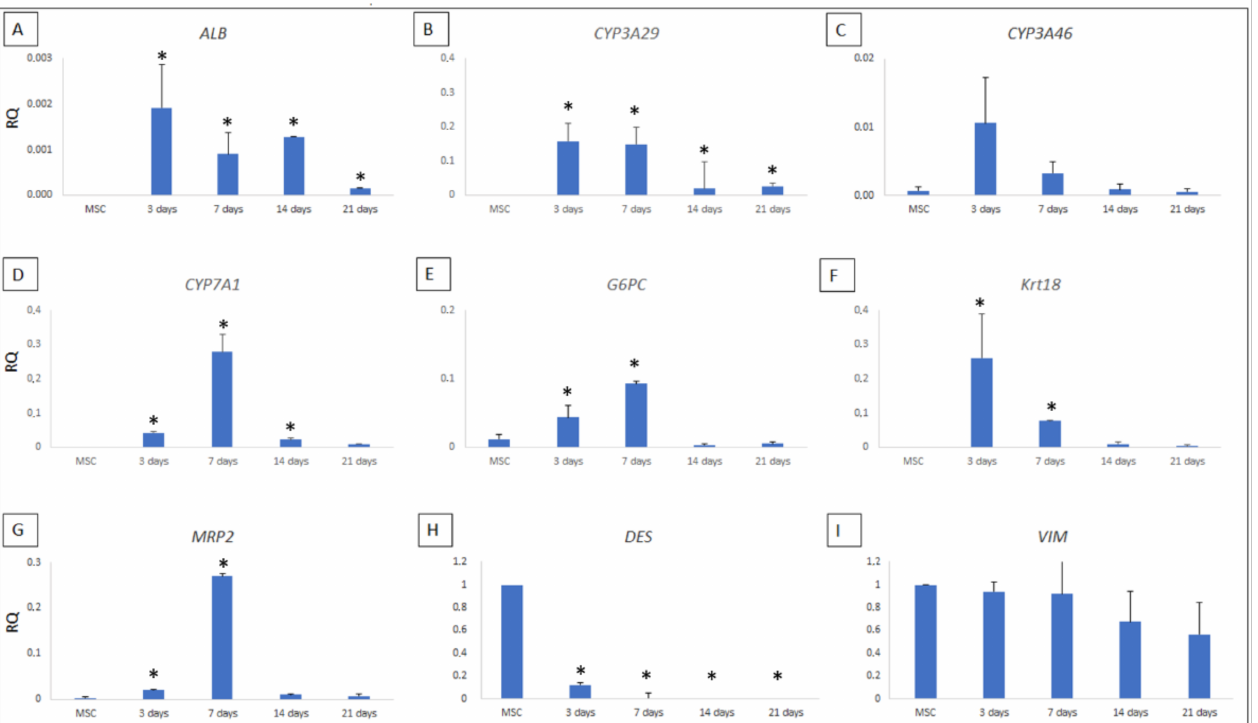
Figure 5. RT-PCR analysis of hepatic genes. The expression levels of the seven hepatic genes showing an increase during the culture on ECM are reported ( A – G ). Desmin and Vimentin were used as MSC-specific markers ( H , I ). The downregulation of desmin represents the staminality loss. Results were expressed as RQ, normalising the gene expression of interest, with GAPDH as an endogenous internal control. As a calibrator, hepatocytes were used for hepatic-specific genes and pMSC for MSC-specific genes (vimentin and desmin). Results are represented as median ± SE ( n = 4). * indicate a significant difference 3D vs 2D cultured pMSCs. The exact p values are reported in the